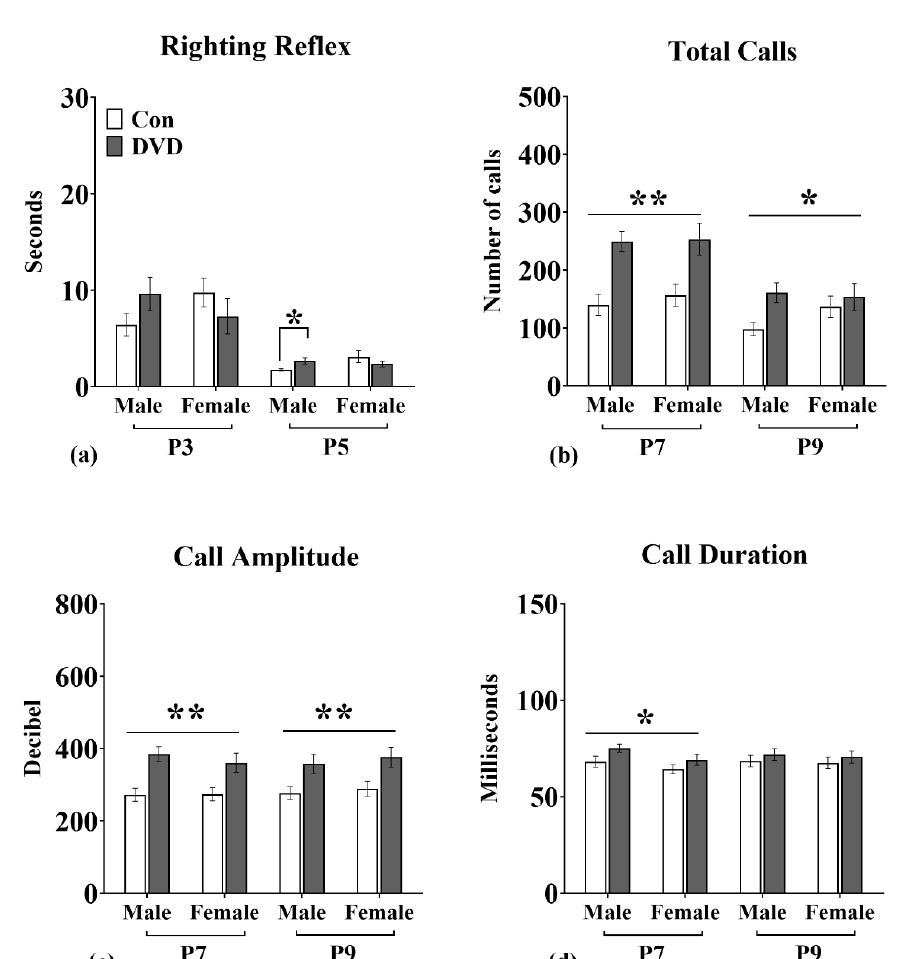
Figure 2. (a) The righting reflex was tested at P3 and P5. There was no effect of developmental vitamin D (DVD)-deficiency on the righting reflex at P3. However, DVD-deficient males showed a delayed latency to right at P5 with no difference in female pups. DVD males n = 49, control males n = 48, DVD females n = 29 and control females n = 43. Data shown is mean time taken by pups to right in seconds. Ultrasonic vocalizations were recorded at P7 and P9. (b) Both DVD-deficient male and female pups emitted significantly greater number and (c) louder calls at P7 and P9 compared with control pups.